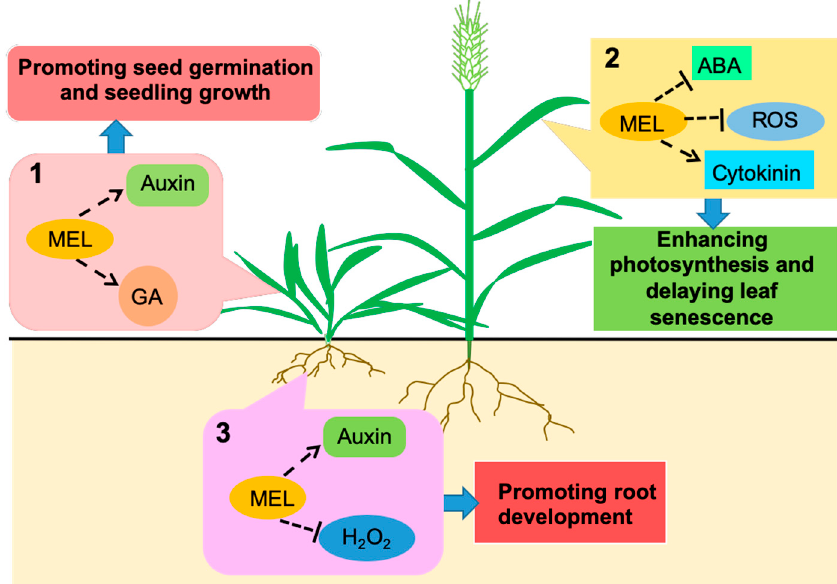
Figure 7. The potential mechanism diagram of MEL on improving wheat grain yield based on the current and previous studies. Three potential mechanisms are involved in MEL improving the wheat yield. (1) During the germination and seedling growth stages, the MEL could promote the auxin and gibberellins (GA) synthesis, increasing the tiller number and seedling growth, which leads to an increase in spike number. (2) During the flowering and grain filling stages, MEL may block abscisic acid (ABA) synthesis and promote cytokinin synthesis, eliminate reactive oxygen species (ROS) and delay leaf senescence and enhance carbon assimilation capacity, which leads to increased grain weight and grain number. (3) In the root, MEL may promote auxin accumulation and eliminate H 2 O 2 and promote root/shoot ratio.